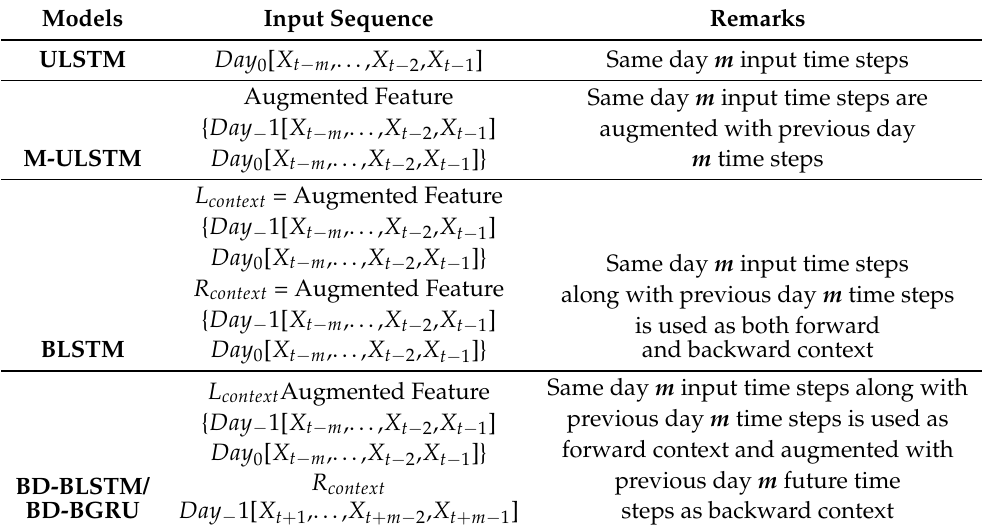
Table 2. Comparison of models with different input feature